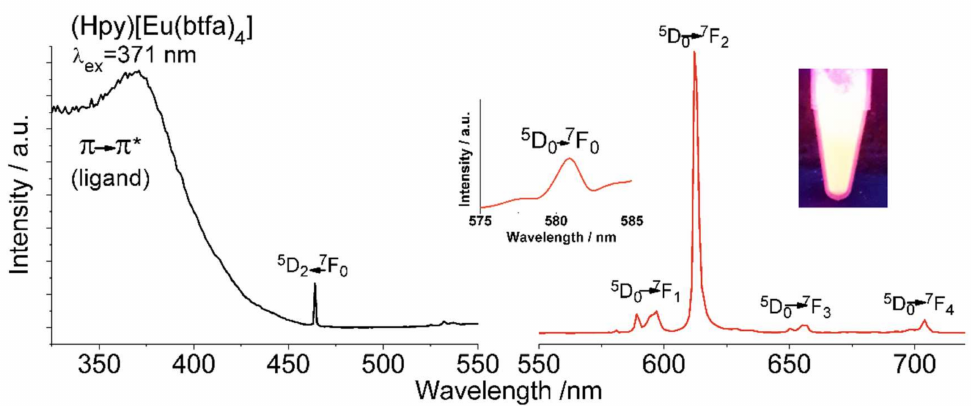
Figure 5. Excitation (black line) and emission (orange line) spectra of 10 . Inset, left, shows an enlarged view of the 5 D 0 → 7 F 0 transition and right the emission color of the complex under UV light radiation.